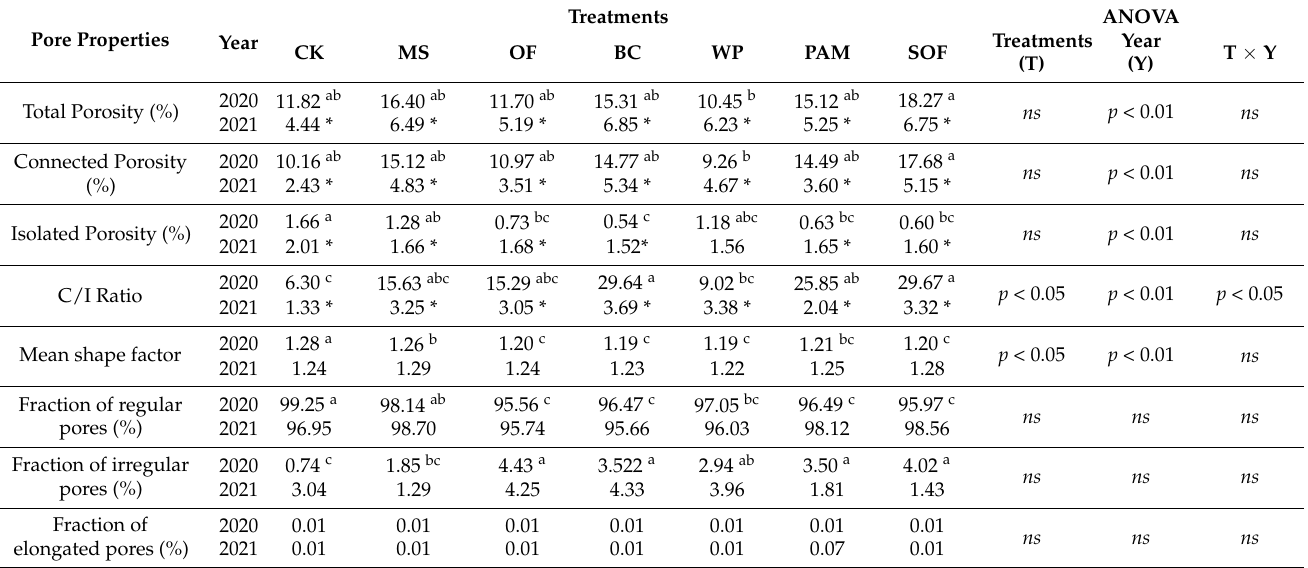
Table 4. Digital image-based calculation of soil porosity and pore shape parameters for 2020 and 2021.